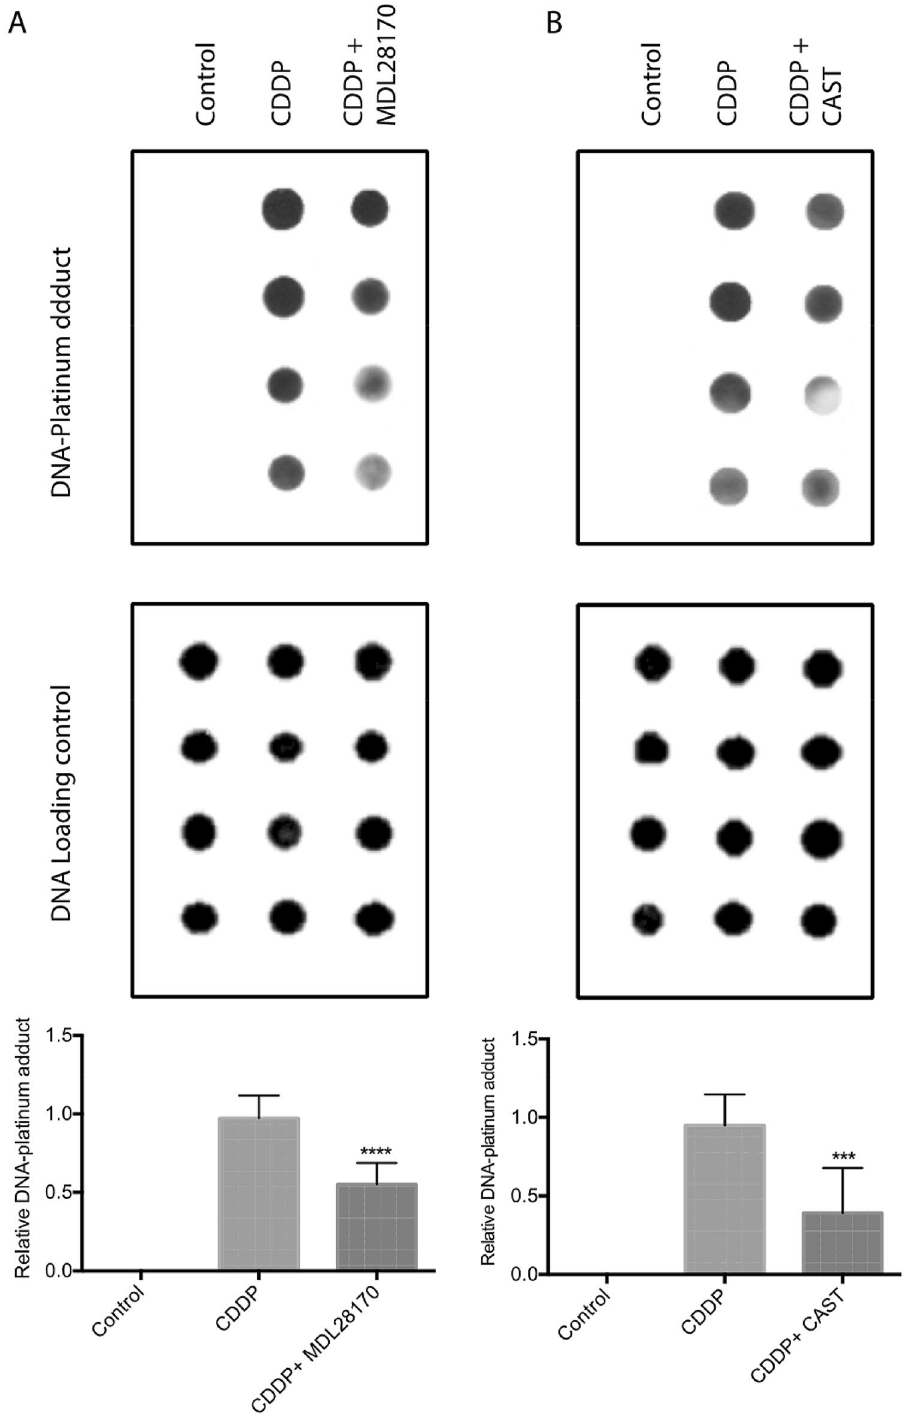
Figure 6. Formation of DNA-platinum adducts by CDDP in neuronal cells was blocked by two additional calpain inhibitors MDL28170 ( A ) and calpastatin ( B ). Uncropped dot blots show representative blots (n = 4) for each condition and quantitation is shown in graphs below each (n = 8 per group, *** p < 0.005, **** p < 0.001, one- way ANOVA with multiple comparisons, error bars denote